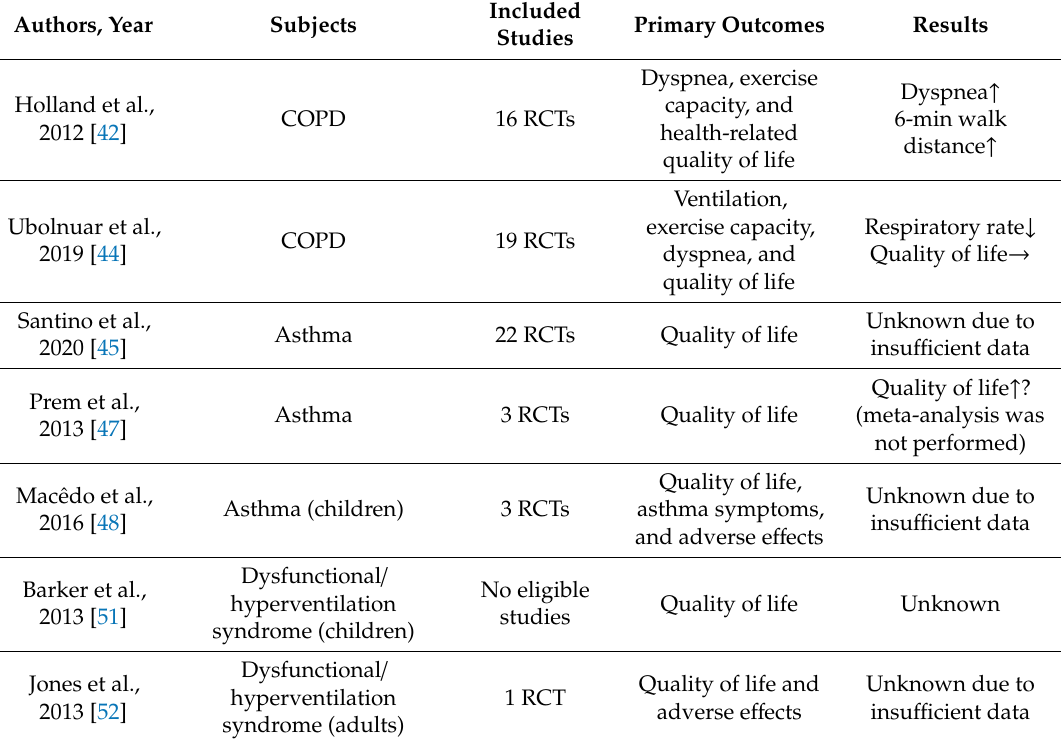
Table 1. Systematic reviews and meta-analyses assessing the e ff ects of diaphragmatic breathing on various